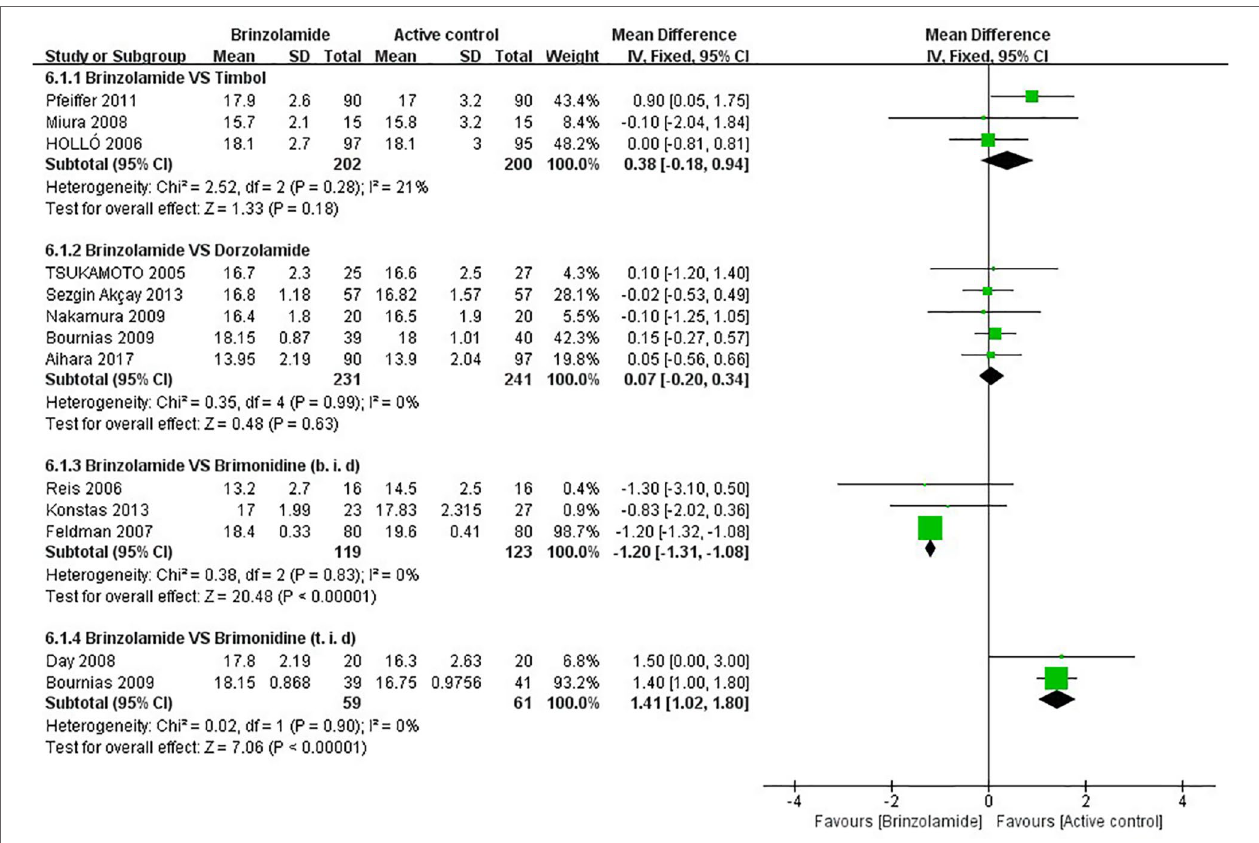
FIGURE 3 | Forest plot for the mean diurnal IOP at the end of treatment duration (Brinzolamide group vs. active control group).The mean diurnal IOP between Brinzolamide group and Timolol group (6.1.1); between Brinzolamide group and Dozorlamide group (6.1.2); between Brinzolamide group and Brimonidine